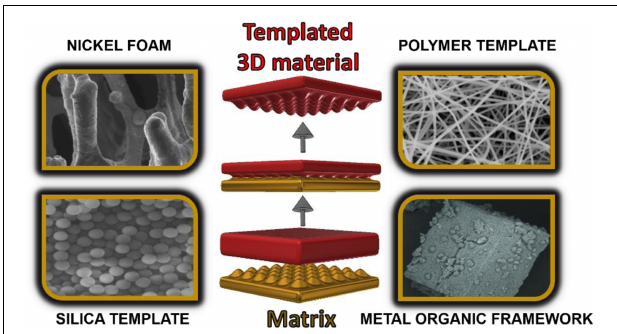
FIGURE 5 | Schematic illustration of template-based 3D materials. SEM pictures adapted from Ahn et al. (2019), Ussia et al. (2019), Zhou (2019),